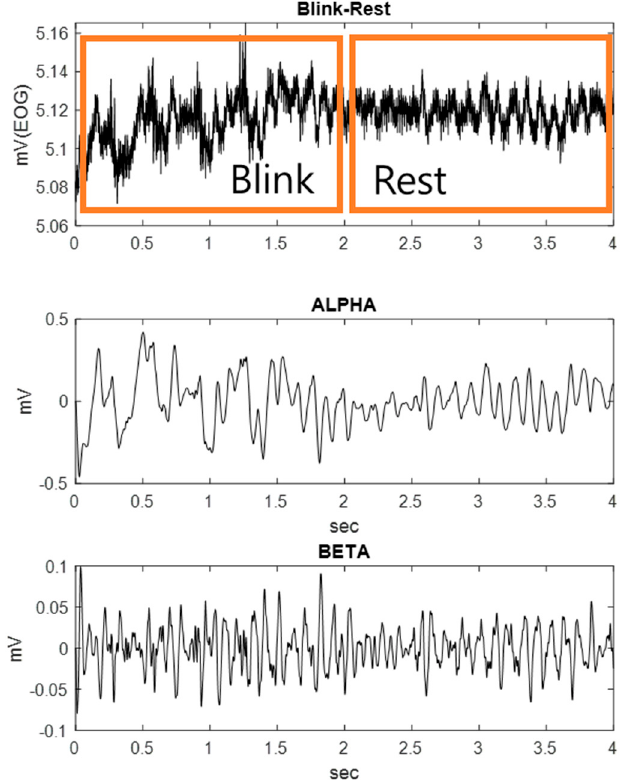
Figure 10. The one channel EOG contains EEG information: alpha and beta waves can be driven to match eye motion.